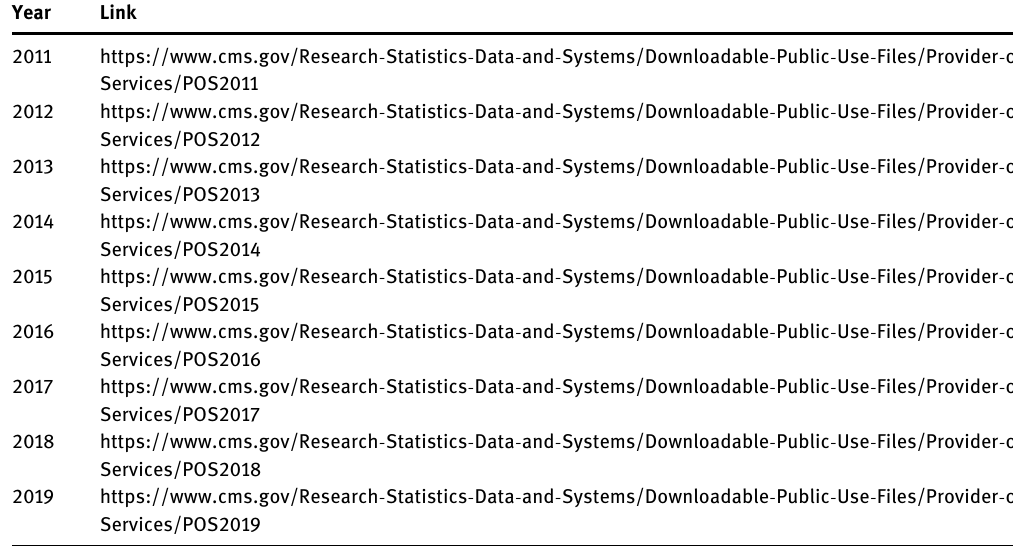
Table A4: Download links for the Provider of Services data